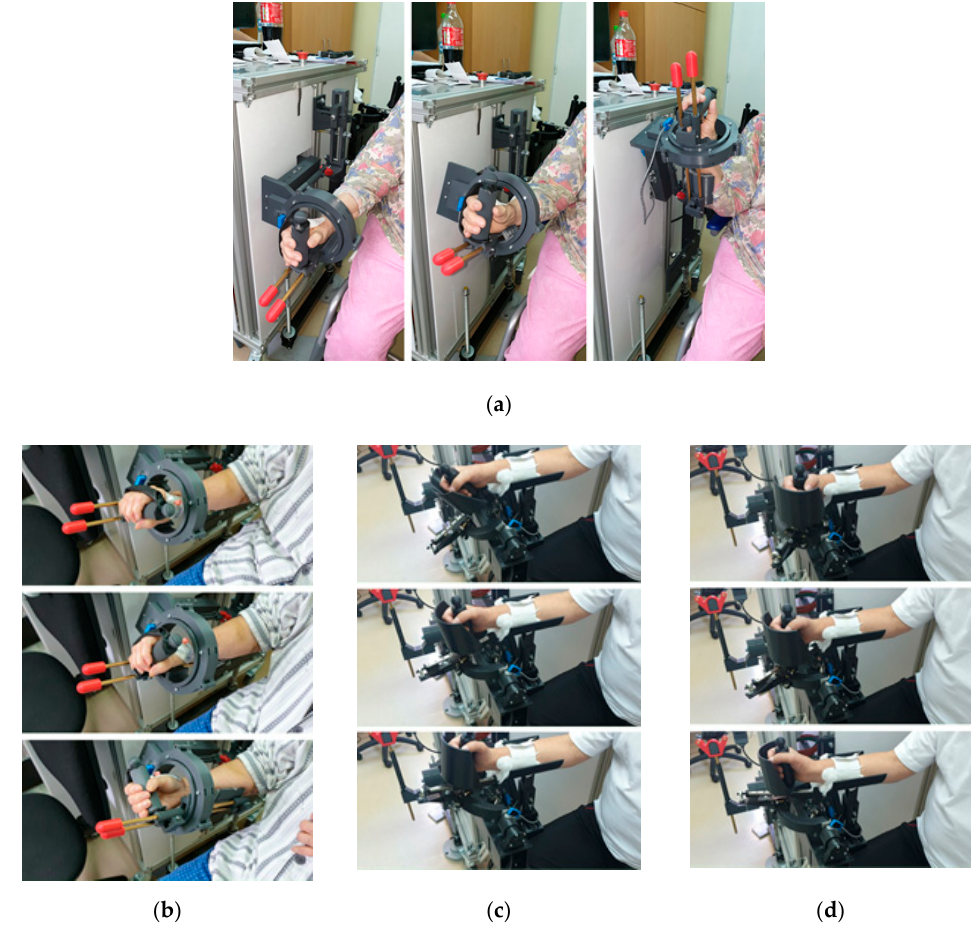
Figure 11. Snapshots from the experimental tests using ParReEx (( a ) ParReEx-elbow flexion / extension, ( b ) ParReEx-elbow pronation / supination, ( c ) ParReEx-wrist adduction / abduction, ( d ) ParReEx-wrist flexion /extension).